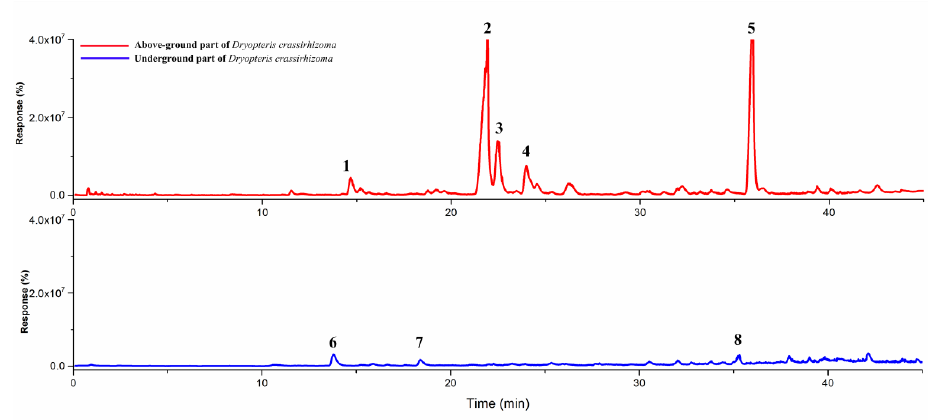
Figure 1. HS-SPME-GC-MS chromatograms of volatile components of above-ground and under- ground parts from D. crassirhizoma .